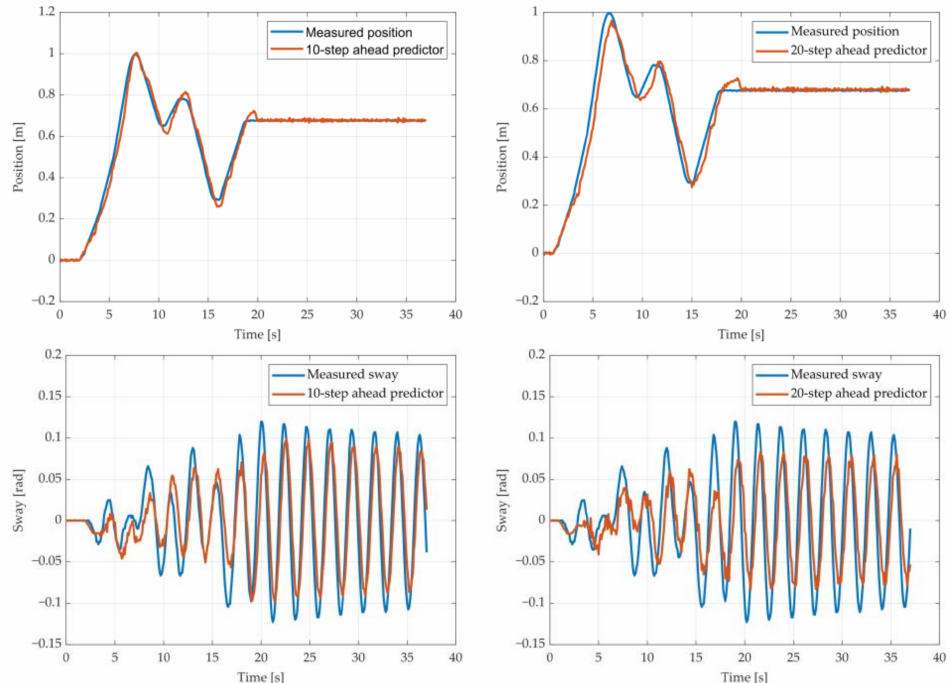
Figure 17. The 10- and 20-step ahead prediction with the ARX model of the experimental crane position and payload sway with 0.9-meter rope and 10 kg payload